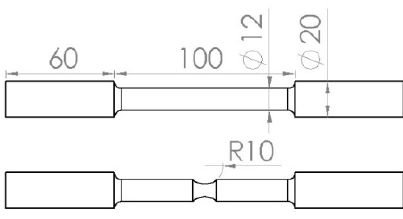
Figure 1. The schematic pictures of plain and notched specimens.